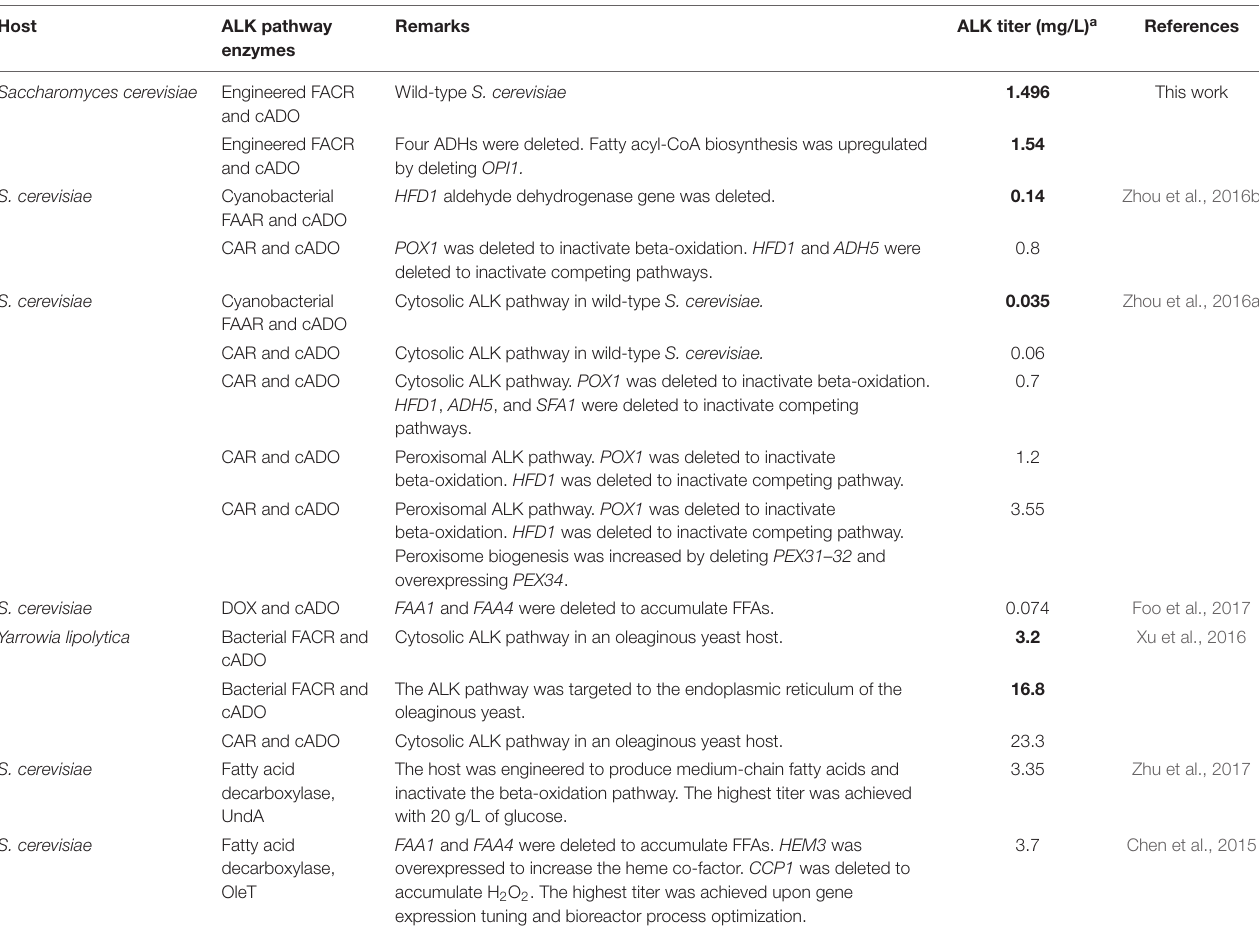
TABLE 2 | Comparison of reported ALK production titers in